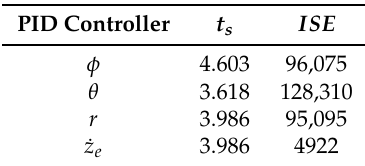
Table 3. Controller performance using the Root-Locus method.